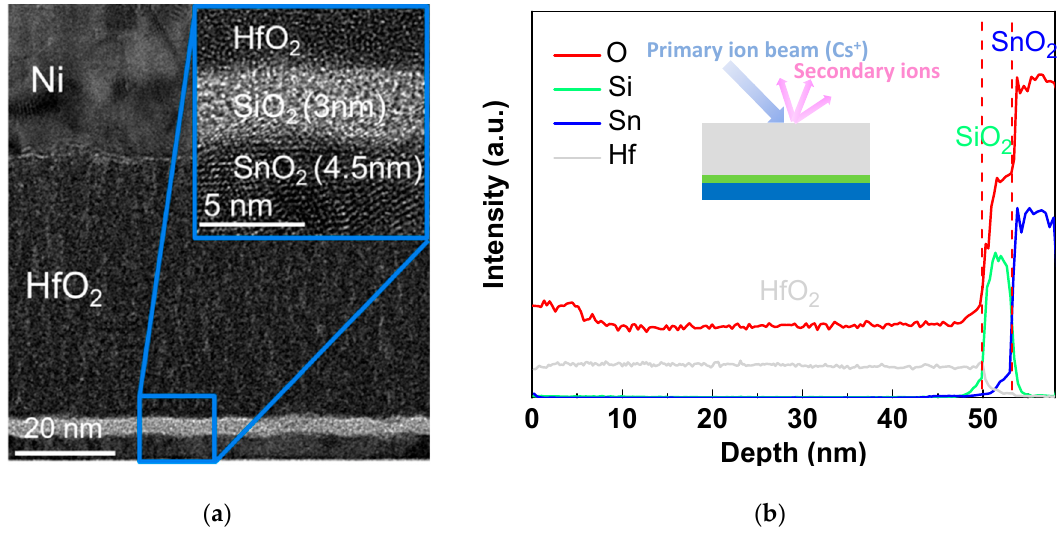
Figure 4. ( a ) The cross-sectional TEM image and ( b ) SIMS depth profiles of the SnO 2 TFT with an SiO 2 interfacial layer.